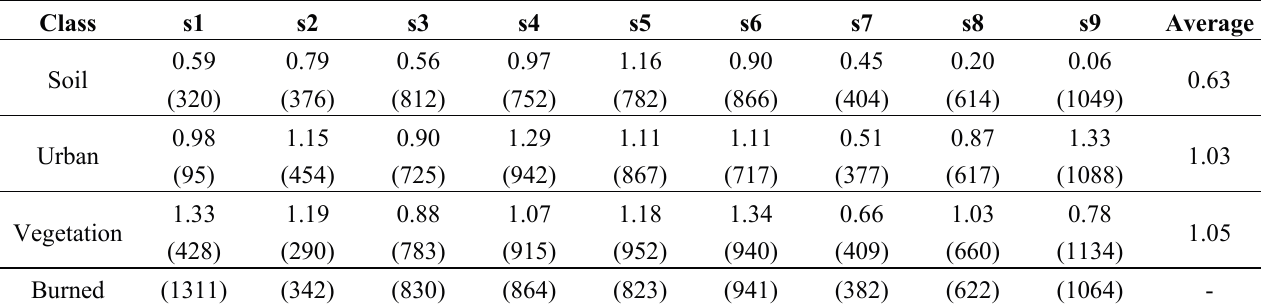
Figure 4. Boxplots (median, interquartile range, maximum and minimum values and outliers) of ∆σ ° (dB) for burned, soil/sparse vegetation, urban and unburned vegetation surfaces over the SAR frames s1–s9. Table 4. The separability , M , between burned and different unburned surface classes (soil/sparse vegetation, urban and unburned vegetation) and for the SAR frames (s1 − s9), and the number of pixels in the training set (in brackets). The average separability is shown in the last